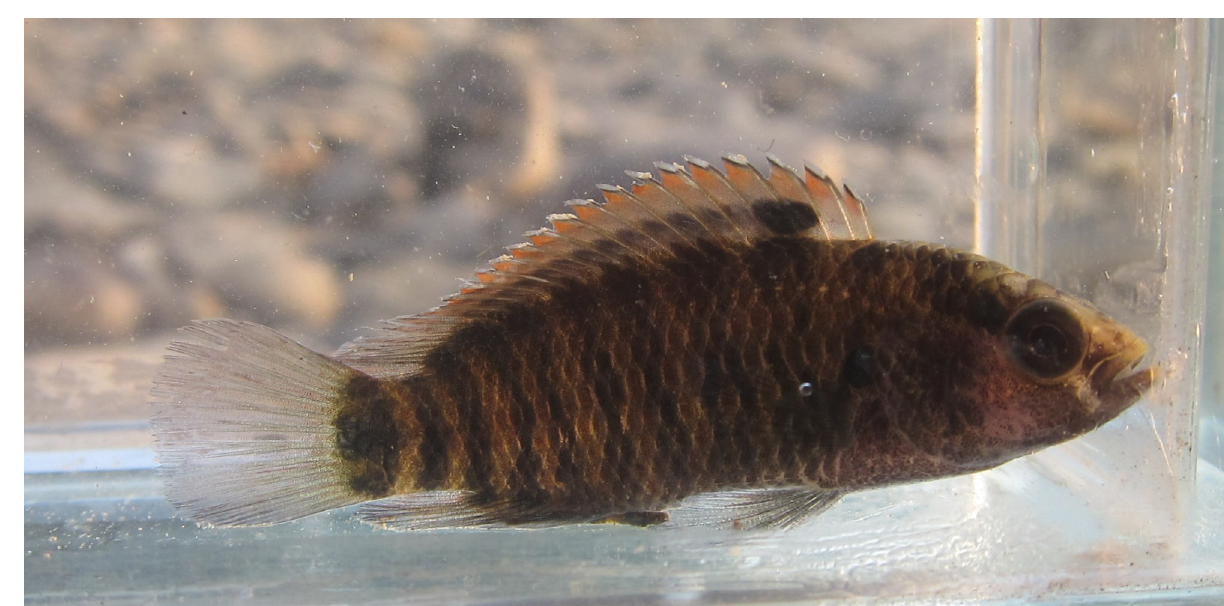
Fig 4. Live individual of Badis kaladanensis . PUCMF 15001, 44.8 mm SL.